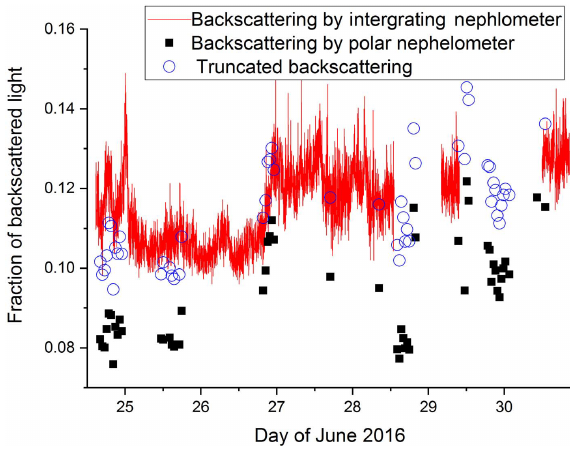
Figure 9. Backscattered fraction measured with the Integrating Nephelometer (red curve) and values obtained by the measured vol- ume scattering function. Simulation of the truncation is shown by the hollow points.